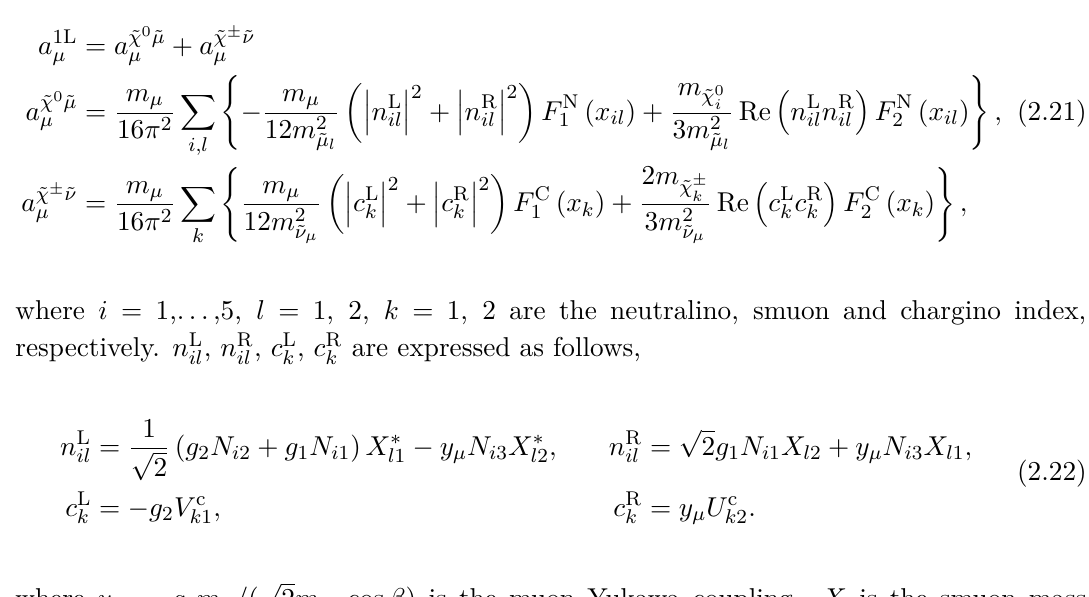
Figure 2 . The two-loop a 2L(a) µ (left) with closed stop loop inserted into an SM-like one-loop di- agram with Higgs and photon exchange, a 2L(b) one-loop diagrams with additional photon loop, or with fermion/sfermion-loop insertion. The ex- ternal photon can couple to each charged